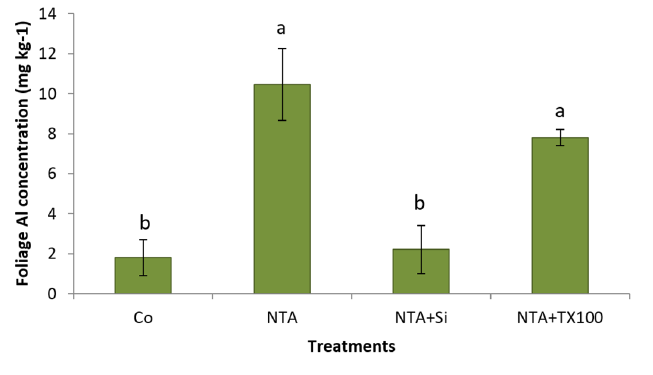
Figure 4. ( a ). Average (+/- SD) foliage Pb concentration (mg kg − 1 ) of Panicum virgatum at time of harvest. The means for columns designated with the same letter are not statistically significantly different ( α = 0.05). (Treatments labeled: Co, control; NTA, NTA 5 mM; NTA+Si, NTA 5 mM + nano-silica, NTA+TX100, NTA 5 mM + Triton X-100). ( b ) Average (+/ − SD) foliage Fe concentration (mg kg − 1 ) of Panicum virgatum at time of harvest. The means for columns designated with the same letter are not statistically significantly different ( α = 0.05). (Treatments labeled: Co, control; NTA, NTA 5 mM; NTA+Si, NTA 5 mM + nano-silica, NTA+TX100, NTA 5 mM + Triton X-100). ( c ) Average (+/ − SD) foliage Al concentration (mg kg − 1 ) of Panicum virgatum at time of harvest. The means for col- umns designated with the same letter are not statistically significantly different ( α = 0.05). (Treat- ments labeled: Co, control; NTA, NTA 5 mM; NTA+Si, NTA 5 mM + nano-silica, NTA+TX100, NTA 5 mM + Triton X-100).